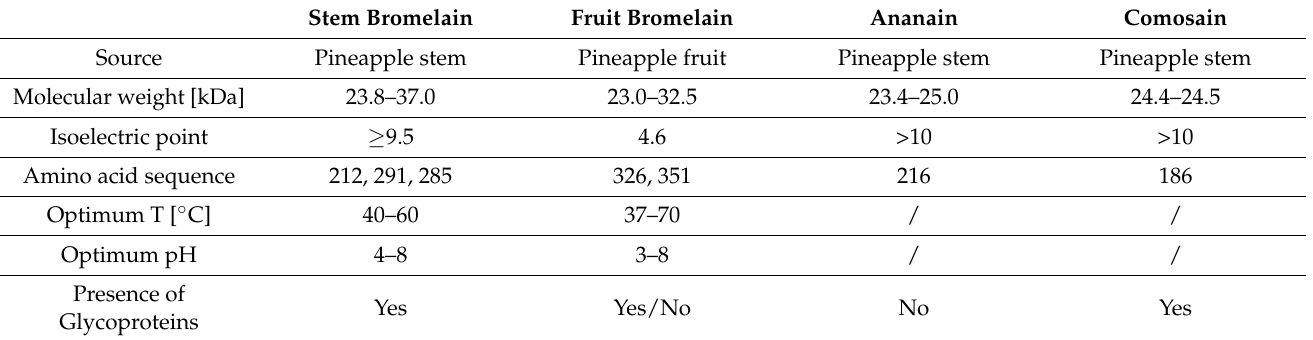
Table 1. Physiochemical properties of cysteine endopeptidases derived from pineapple plants